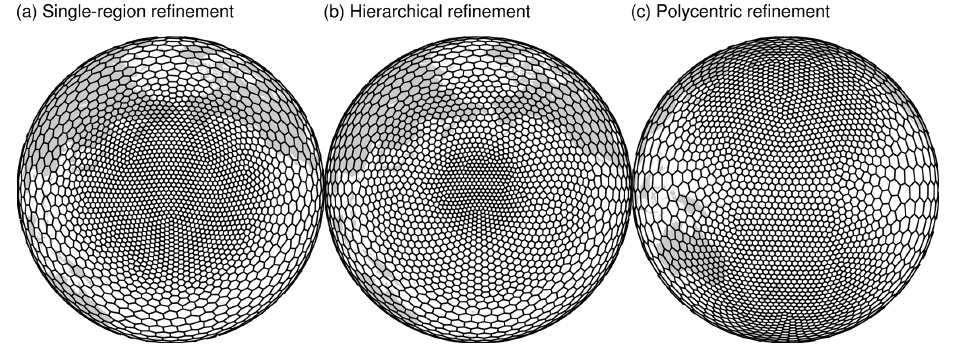
Figure 1. An illustration of the variable-resolution mesh (X4) based on three density functions: (a) single-region refinement, (b) hierarchical refinement, and (c) polycentric refinement. Throughout this paper, all land–sea outlines are only given for a spatial reference and do not represent the geographical